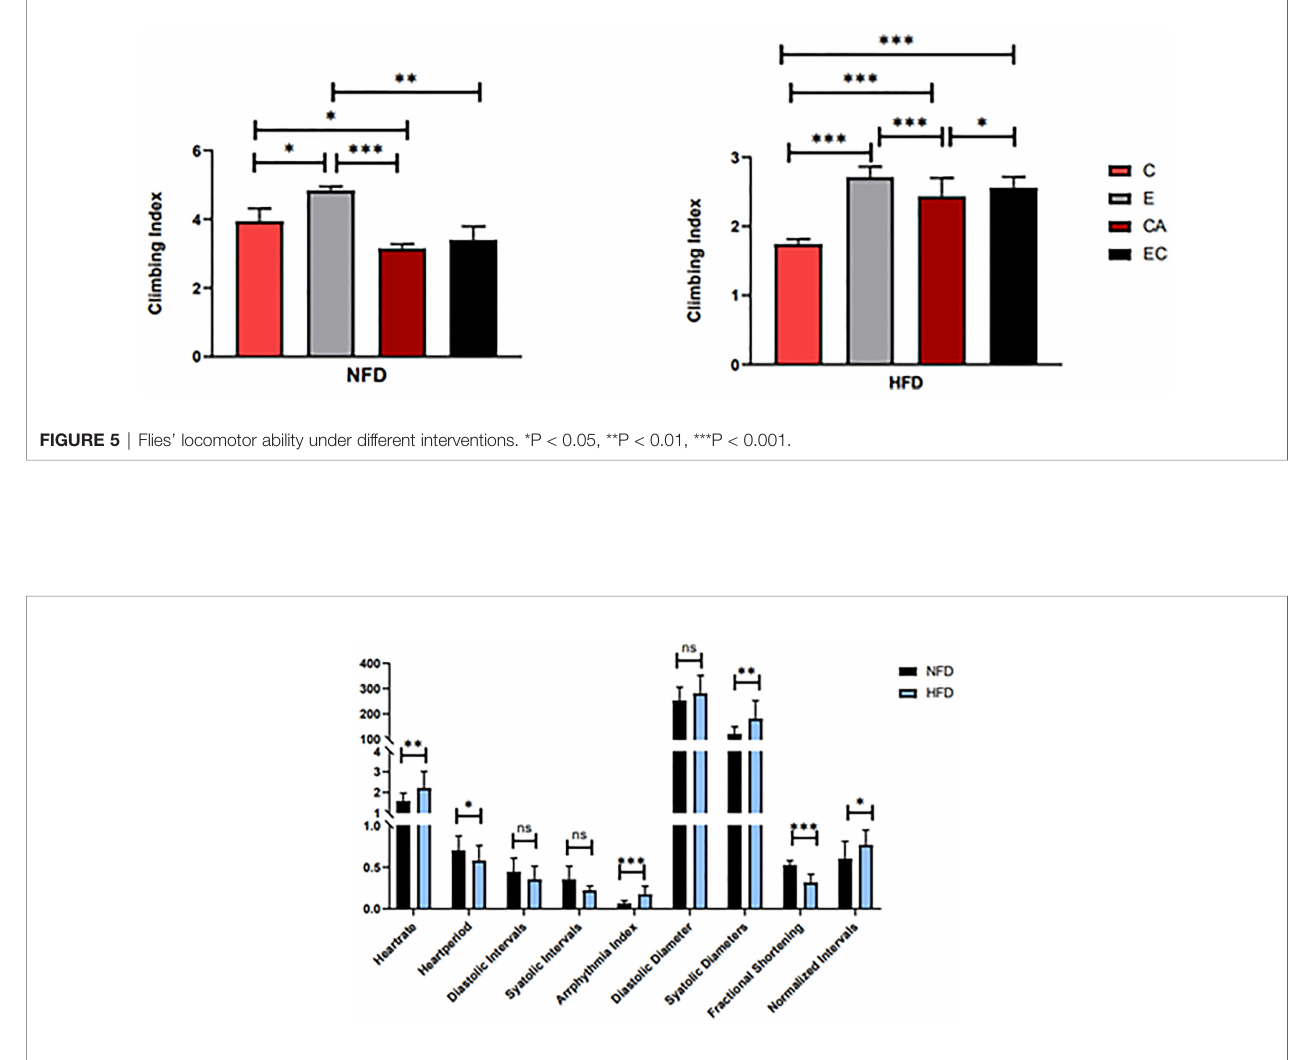
FIGURE 6 | Heart function in HFD and NFD fruit fl ies. *P < 0.05, **P < 0.01, ***P < 0.001, ns P > 0.05.